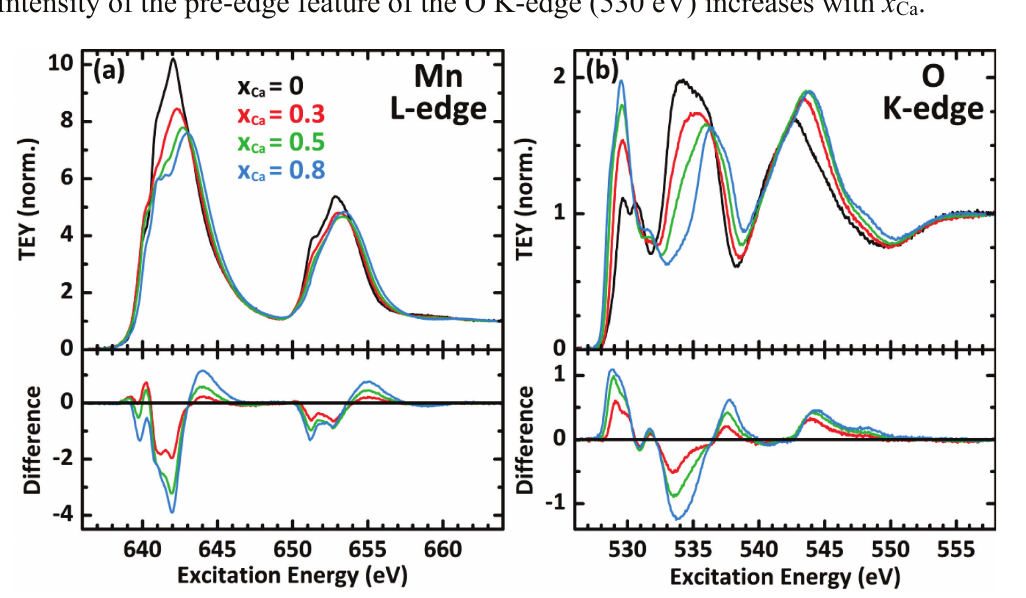
UHV. ( a ) The Mn L-edge shows the systematic increase in Mn valence with increasing x ( b ) Intensity of the pre-edge feature of the O K-edge (530 eV) increases with x